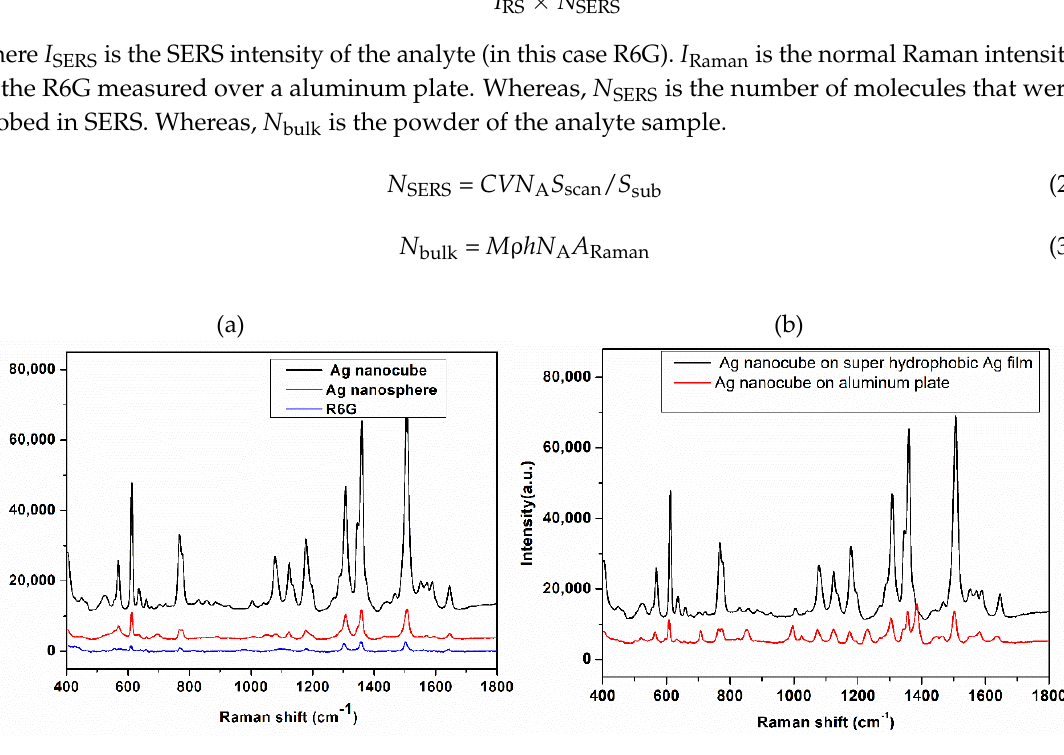
Figure 4. ( a ) SERS spectra of 10 − 7 M R6G mixed with AgNCs and Ag nanospheres on the super-hydrophobic silver film and the normal Raman spectra of R6G powder; ( b ) SERS spectra of 10 − 7 M R6G mixed with AgNCs on the super-hydrophobic silver film and the aluminum plate. C is the molar concentration for analyte solution, V is the volume of the droplet = 3 µ L in SERS, S scan is the area of Raman scanning, S scan = 5.0 µ m 2 , and S sub is the area of the